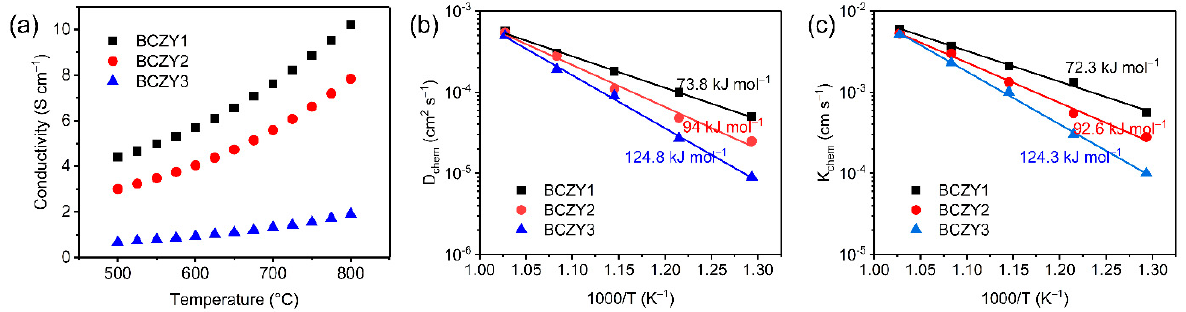
Figure 5. ( a ) Electrical conductivities of BCZY1, BCZY2, BCZY3 in air; Arrhenius plots of ( b ) D chem and ( c ) K chem values of BCZY samples obtained by